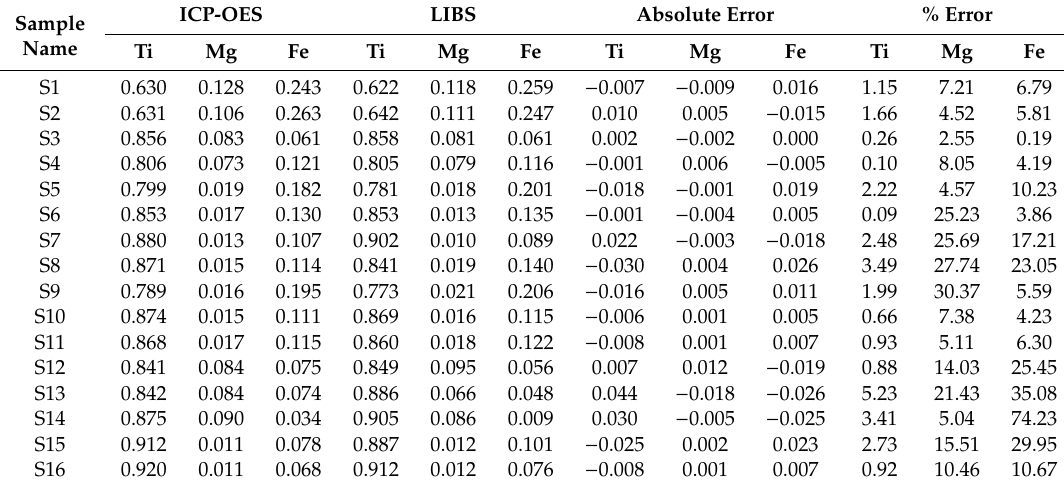
Table 4. Comparative result of ICP-OES and LIBS elemental analysis and error